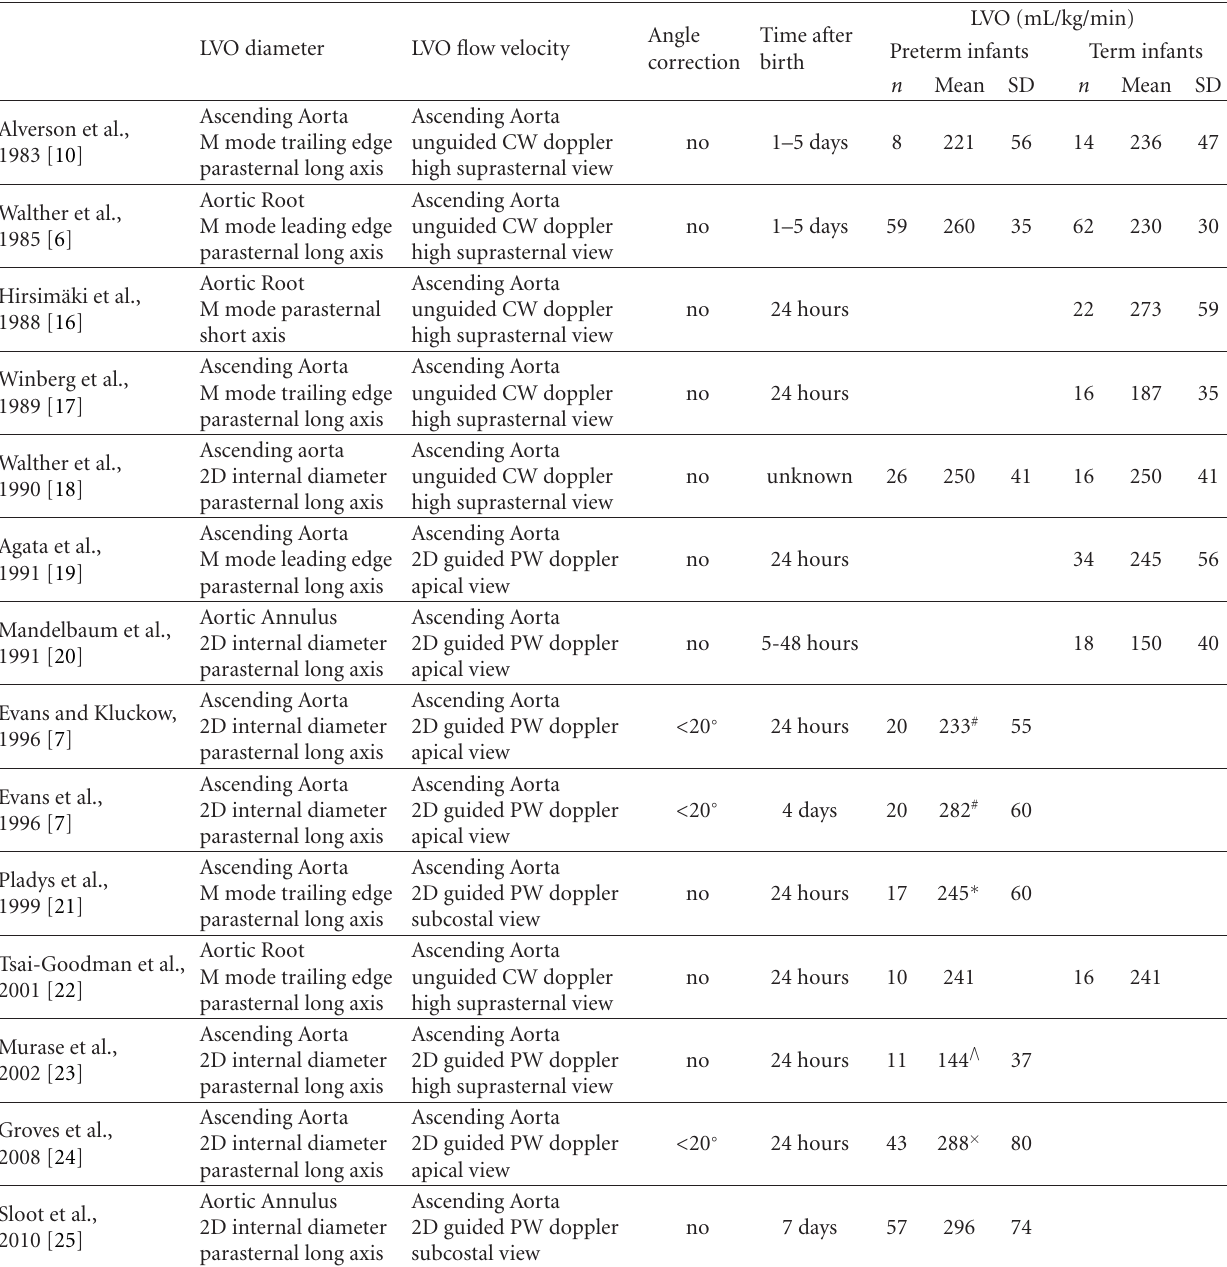
Table 1: Methods of determination of LVO diameter, flow velocity, and reported mean (SD) values in